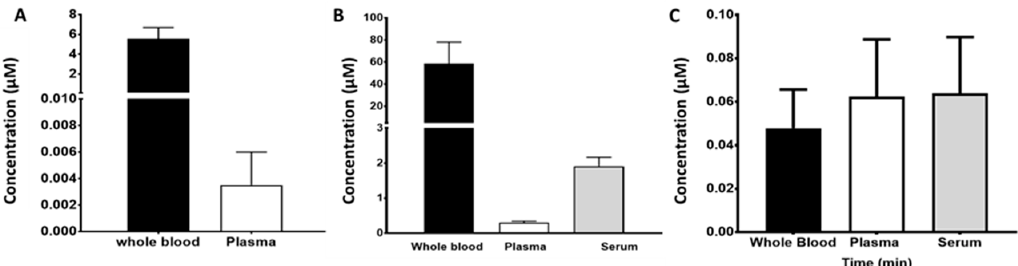
Figure 7. The steady state concentrations of gefitinib ( A ), erlotinib ( B ), and afatinib ( C ) in different blood compartments. Samples for gefitinib (whole blood and plasma) were obtained after an average of 124 ± 67 days at 250 mg per dose level. Samples for erlotinib were obtained after an average of 238 ± 167 days at 150 mg per dose level. Samples for afatinib were obtained after 4 days following standard 40 mg oral dosing per day. Values are the means ± standard error of the mean of 4 or more replicates as indicated in the